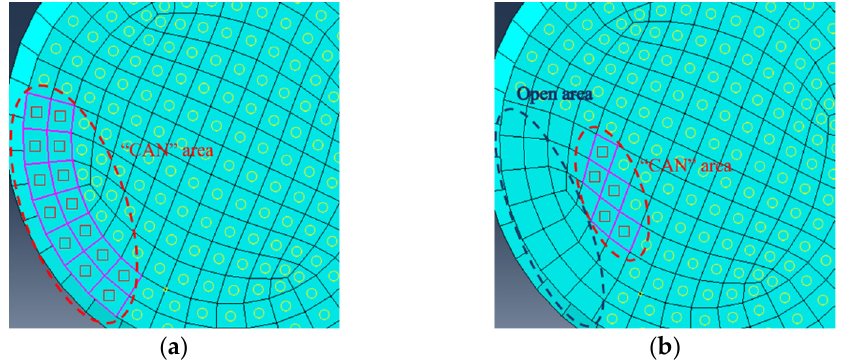
Figure 11. Modeling of “breathing” crack. ( a ) “CAN” area of fully “breathing” crack. ( b ) “CAN” area of partially “breathing” crack.